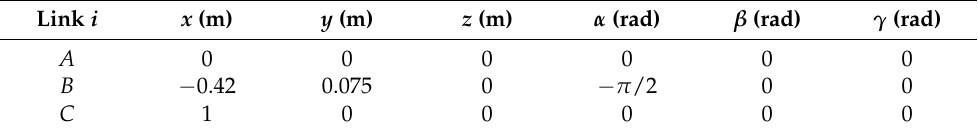
Each individual homogeneous transformation matrix i − 1 ing the homogeneous transformation matrix i − 1